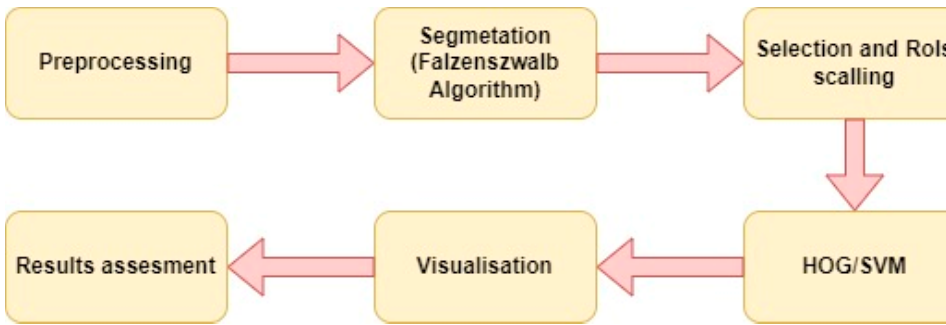
Figure 2. A block diagram of the HOG/SVM-based detection process.